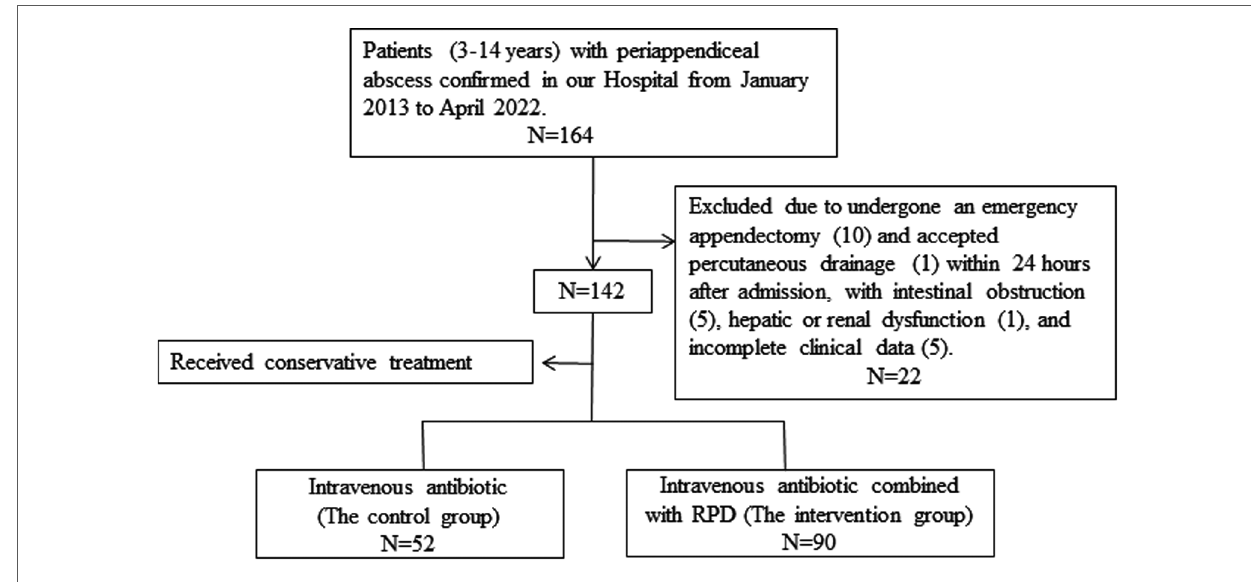
FIGURE 1 Study fl owchart.